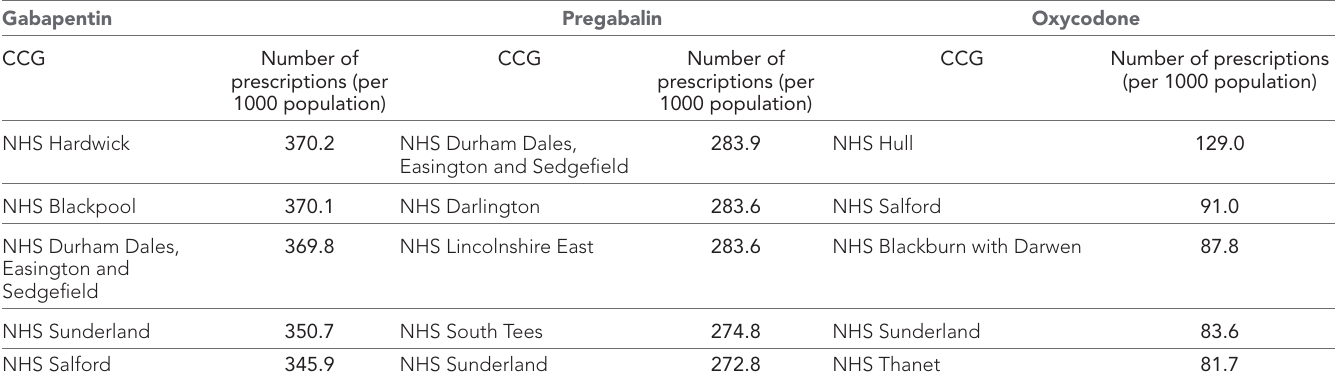
Table 4 CCGs with the highest total number of gabapentin, pregabalin, and oxycodone prescriptions per 1000 population in